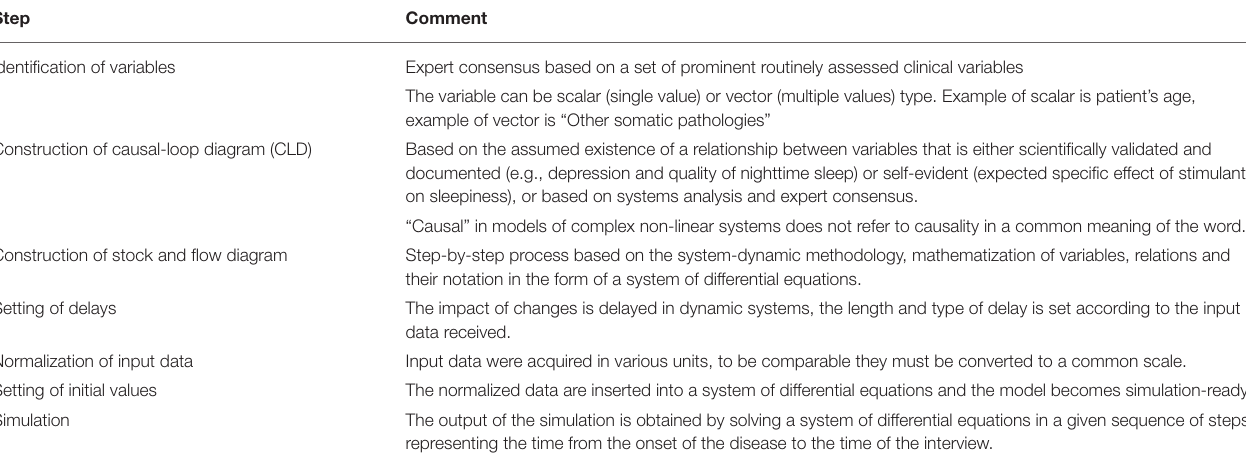
TABLE 3 | Procedure of dynamic model creation and